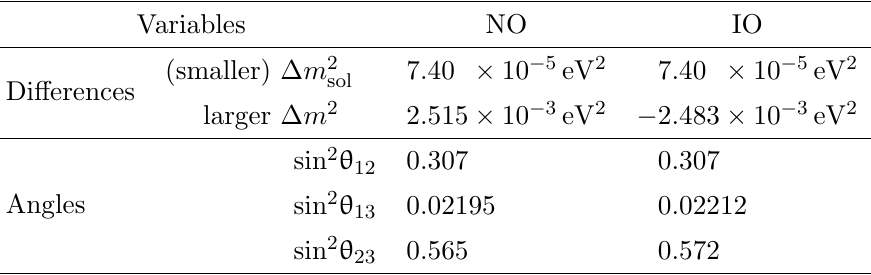
Table 2. Best (cid:12)t values of neutrino mass di(cid:11)erences and mixing angles from the NuFIT 3.1 release by the (cid:23) -(cid:12)t collaboration [77, 78], for \normal ordering" (NO) and \inverted ordering" (IO). The mass di(cid:11)erences are de(cid:12)ned in table